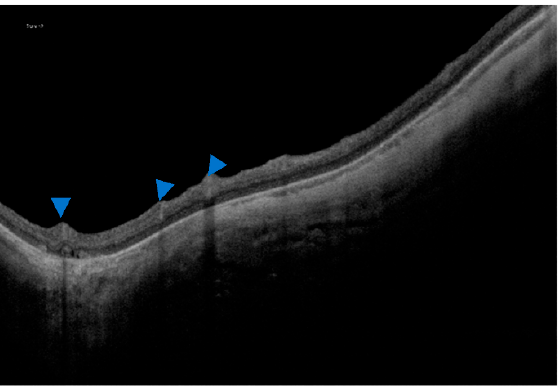
Figure 13. In an OCT scan, the blue arrowheads indicate vascular folds.